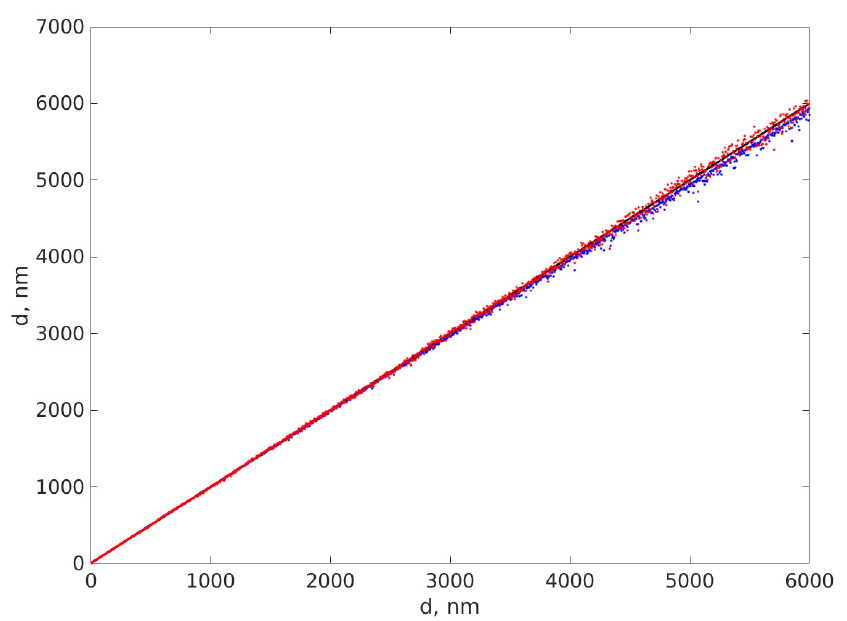
Figure 5. DLS diameters (blue dots); the SEN diameters (red dots); generated diameters (black continuous line); versus the generated diameters.